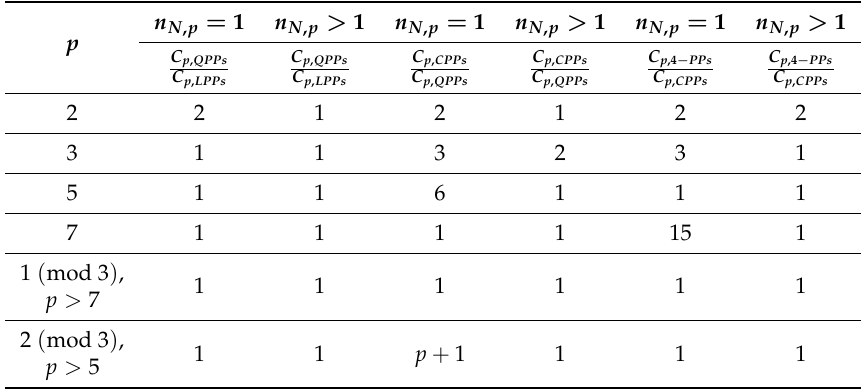
for d = 2,3,4. C p , ( d − 1 ) − PPs